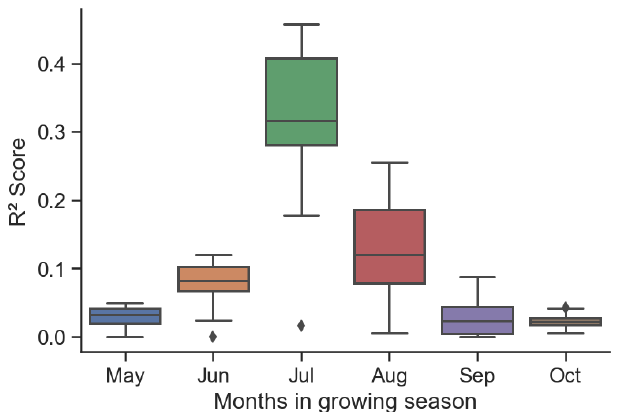
Figure C6. Coefficient of determination between soybean yields and all meteorological variables considered in this study grouped by month of the growing season.